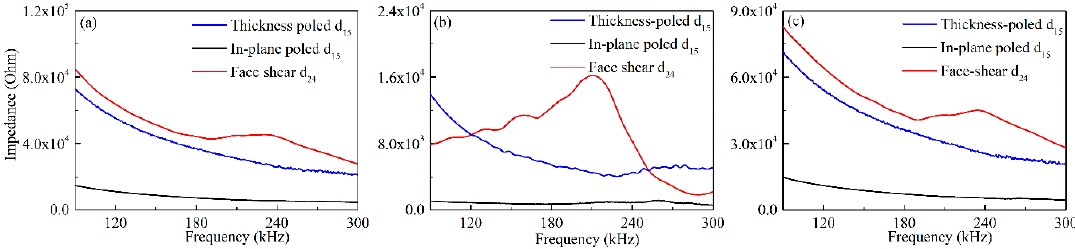
Figure 5. The impedance spectrum of three types shear mode piezoelectric wafers with the same dimensions of 8 mm × 8 mm × 1 mm bonded on the aluminum plate: ( a ) impedance; ( b ) resistance; ( c ) reactance.